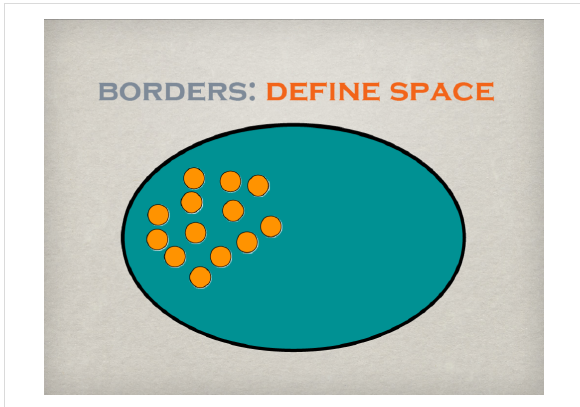
Figure 5: The available space for opportunities may be explored but does not necessarily need to be. Selectivity